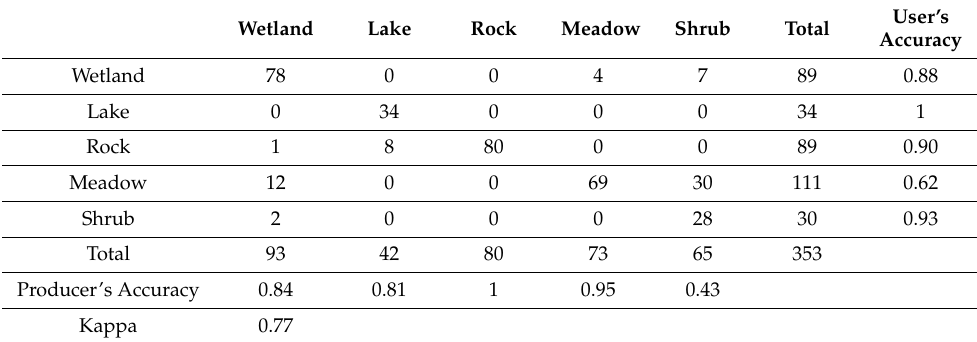
Table 2. Confusion Matrix of Supervised Classification for Landsat 5 TM image in 2004.